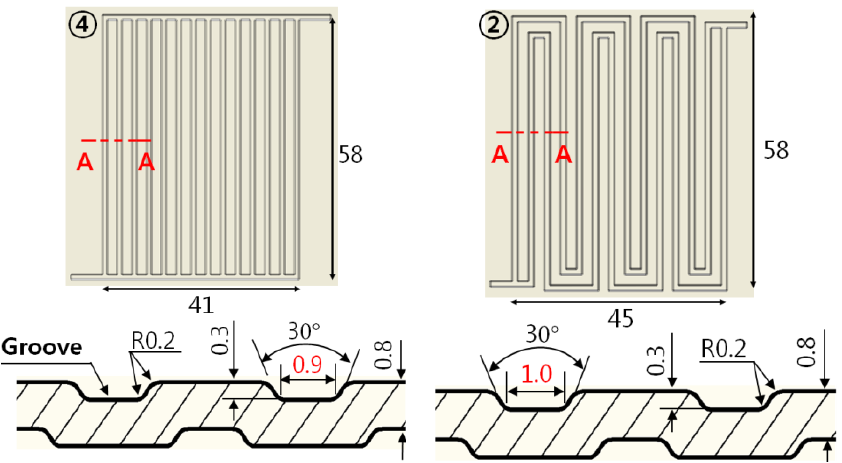
Figure 2. Detail view of four mazes (unit: mm): ① maze 1; ② maze 2; ③ maze 3 and ④ maze 4.